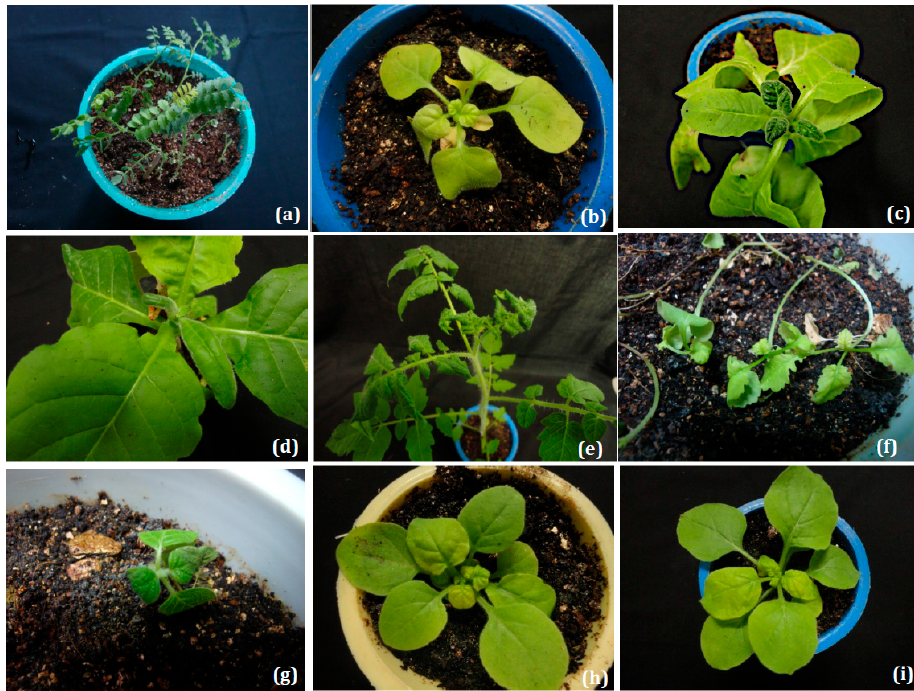
Figure 3. Symptoms in various hosts with agro-inoculated CpCDV-C. ( a ) Chickpea plants showing extreme reduction in leaf size, stunting, yellowing of terminal leaves, dwarfing and proliferation of axillary buds, drying, and eventual death. ( b ) N. benthamiana showing severe stunting, chlorosis, downward folding of margin and reduction of leaf lamina, ( c ) N. glutinosa showing severe stunting, small thick green leaves and backward curling of apical leaves followed by reduction in shoot elongation; ( d ) N. tabacum showing thickening of leaves, crumpling, and reduction in leaf lamina. ( e ) Tomato plants showing young leaves became thick, dark green and mild backward leaf curling ( f ) mustard (Family Brassicaceae ) plants showed typical chlorosis, downward marginal folding, and stunted ( g ) Sesame (Family Pedaliaceae , variety Uma), produced very severe symptoms with thickening of leaves, downward folding, crumpling, and reduction of leaf lamina. N. benthamiana agro-inoculated with CpCDV + ToLCNDV DNA B ( h ) and CpCDV+CLCuMuB-[IN:Sr:02] ( i ) showing typical CpCDV symptoms.